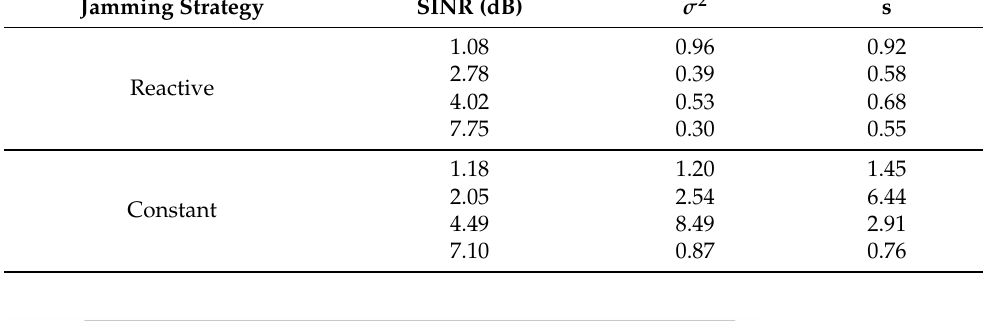
Table 4. Variance and standard deviation for different experiments and for reactive and constant jamming strategies. The variance of the experiments with a reactive jammer is lower than the constant strategy despite the SINR value. Jamming Strategy SINR (dB) σ 2